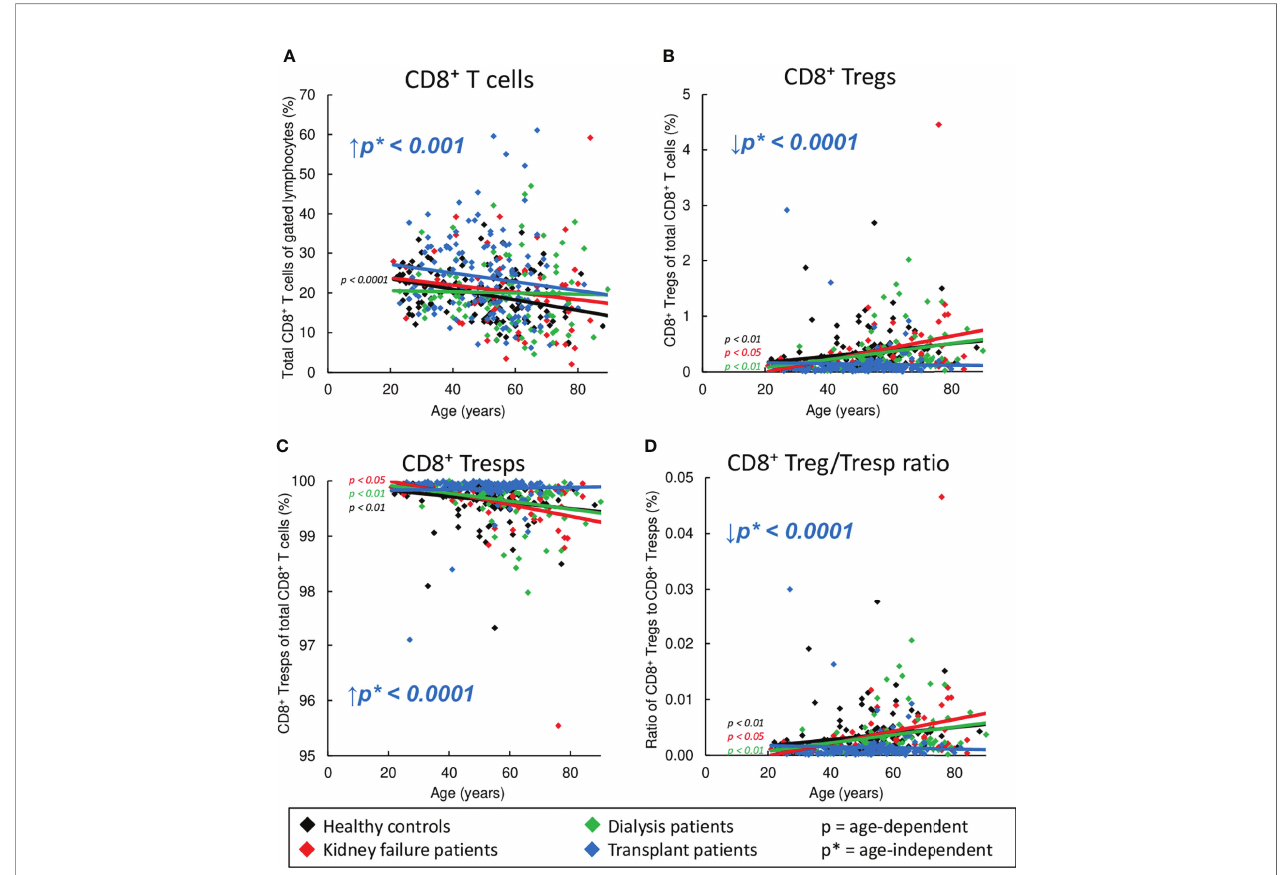
FIGURE 2 | Changes in the composition of CD8 + T cells with Tregs and Tresps in healthy controls (n=134), KF patients (n=57), dialysis patients (n=87), and kidney transplant patients (n=138). The diagrams show the percentages of CD8 + T cells of all lymphocytes (A) , CD8 + CD127 low+/- FoxP3 + Tregs (B) and CD8 + CD127 +/- FoxP3 - Tresps (C) within total CD8 + T cells as well as the CD8 + Treg/Tresp ratio (D) in healthy volunteers ( ♦ ), KF patients ( ♦ ), dialysis patients ( ♦ ), and kidney transplant patients ( ♦ ). Regression lines concerning changes in the percentages with age are shown for both healthy volunteers and all patient groups. Signi fi cant changes are marked by color-matched p-values. Age-independent signi fi cant differences between healthy volunteers and study groups are marked by an arrow ( ↑↓ ) and their color-matched